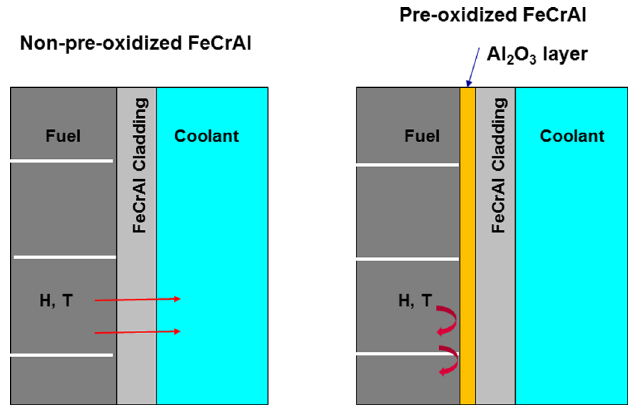
Fig. 9. Schematic representation how an alumina layer will impede the diffusion of tritium from the fuel to the